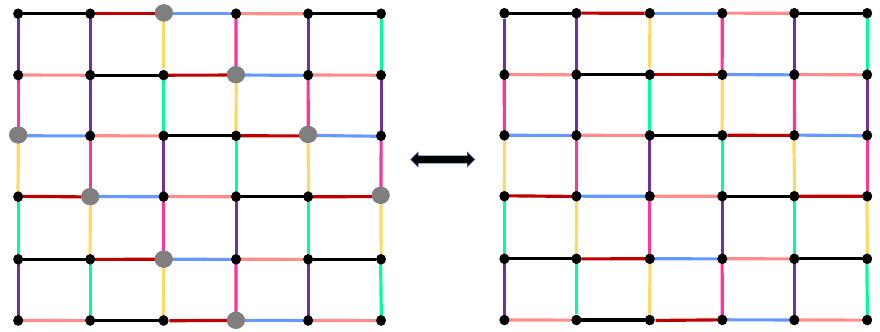
FIG. 25. The physical and logical Hilbert spaces for supercompact encoding. The left-hand side is the physical Hilbert space, where each black vertex contains one qubit, and each gray vertex contains two qubits. The right-hand side is the logical Hilbert space, where each vertex encodes a fermionic mode. The qubit-fermion ratio r is 1.25 in this setting.